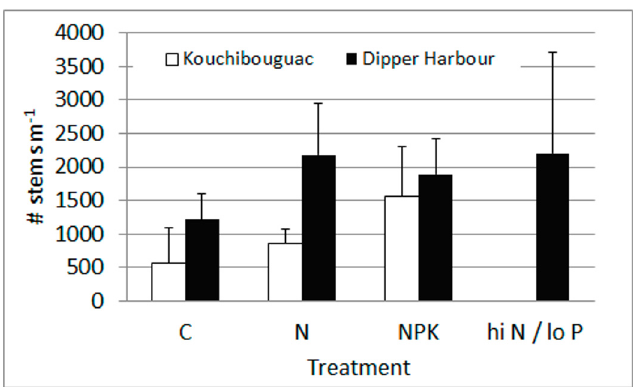
Fig 2. Average number of grass stems in plots by treatment. Error bars = ± 1 sd. Treatment codes are explained in text and caption for Fig 1.